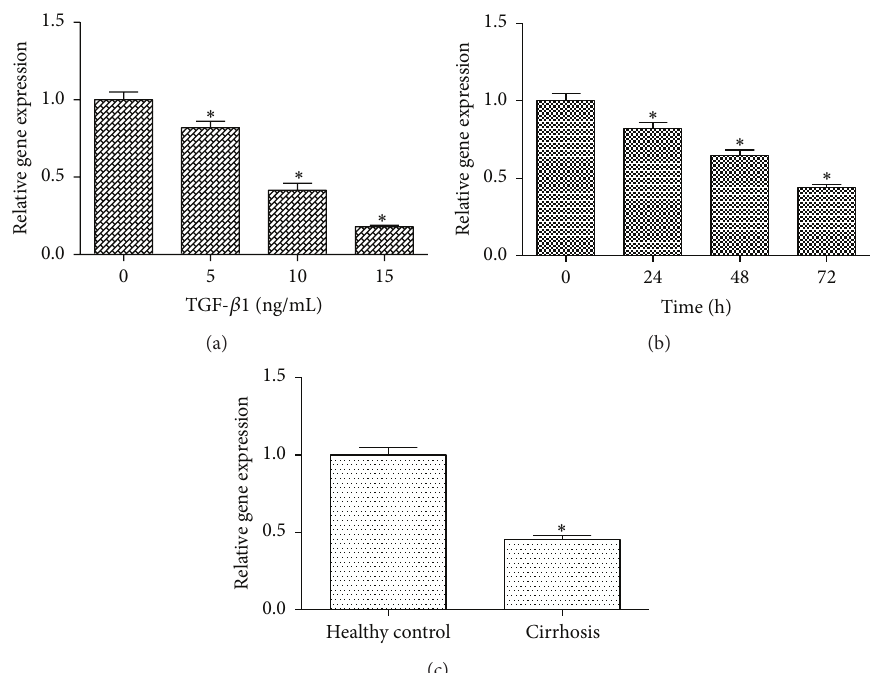
Figure1:lincRNA-p21isdownregulatedinTGF- 𝛽 1-treatedHSCsandhumanliverfibrosis.(a)ThedownregulationoflincRNA-p21expression was dose-dependently induced by TGF- 𝛽 1. LX-2 cells were treated with TGF- 𝛽 1 (0, 5, 10, and 15ng/mL) for 24 h. (b) The downregulation of lincRNA-p21 expression was time-dependently induced by TGF- 𝛽 1. LX-2 cells were treated with TGF- 𝛽 1 (5ng/mL) for 0, 24, 48, and 72 h. (c) Expression of lincRNA-p21 in liver tissues of healthy controls ( 𝑛 = 15 ) and cirrhotic patients ( 𝑛 = 15 ). Each value is the mean ± SD of three experiments. ∗ 𝑃 < 0.05 compared with the